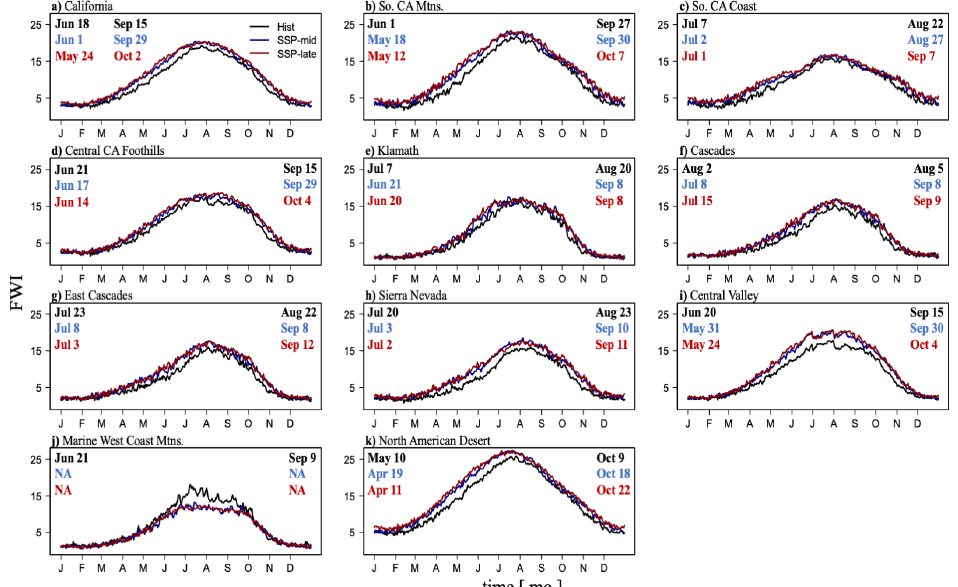
Figure 11. Thirty-year average Julian day Fire Weather Index value by ecoregion. The black, blue, and red lines represent the historical, mid-century, and late-century averages, respectively. The color-coded text shows the average date for each respective time period that FWI exceeds ( left ) and falls below ( right ) a value of 15. ( a ) California; ( b ) Southern California Mountains; ( c ) Southern California Coast; ( d ) Central California Foothills; ( e ) Klamath; ( f ) Cascades; ( g ) East Cascades; ( h ) Sierra Nevada; ( i ) Central Valley; ( j ) Marine West Coast Mountains; ( k ) North American Desert. Studies show that the role of temperature and humidity are strongest in FWI, with precipitation and wind speed playing important, but secondary roles [30,31]. However, our results indicated that the increase of VPD in the mid- and late-century periods was much greater than FWI, especially in the MWCM, which experienced a decrease in sum-